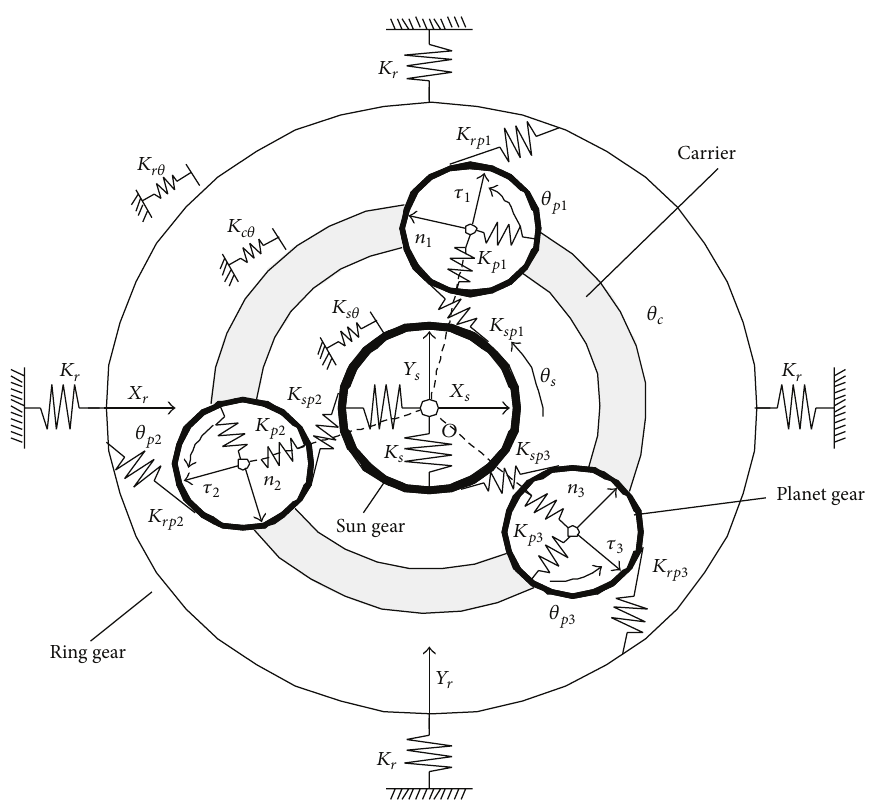
Figure 2: The planetary gear transmission system dynamic model.